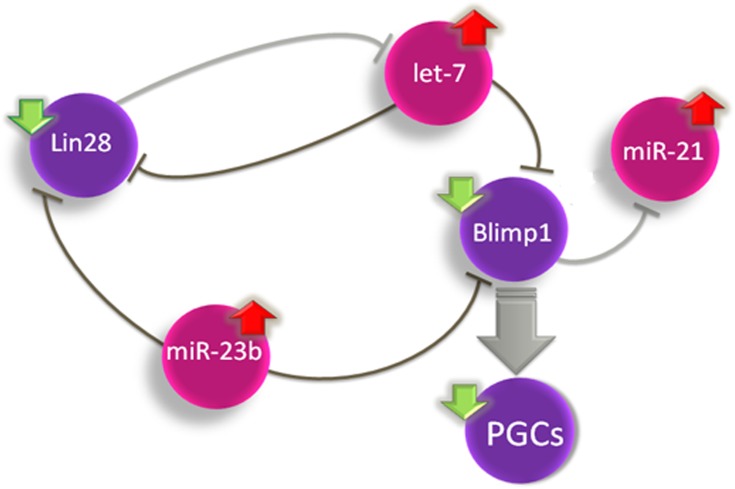
Schematic model for the deregulation of PGC development by the Lin28/let-7/Blimp1 pathway in the PGCs from mice exposed to VCZ.Red arrows indicate upregulation and green arrows indicate downregulation. miRNAs are illustrated in pink. A consequence of the downregulation of BLIMP1 is the reduction in the number of PGCs in embryonic testis.